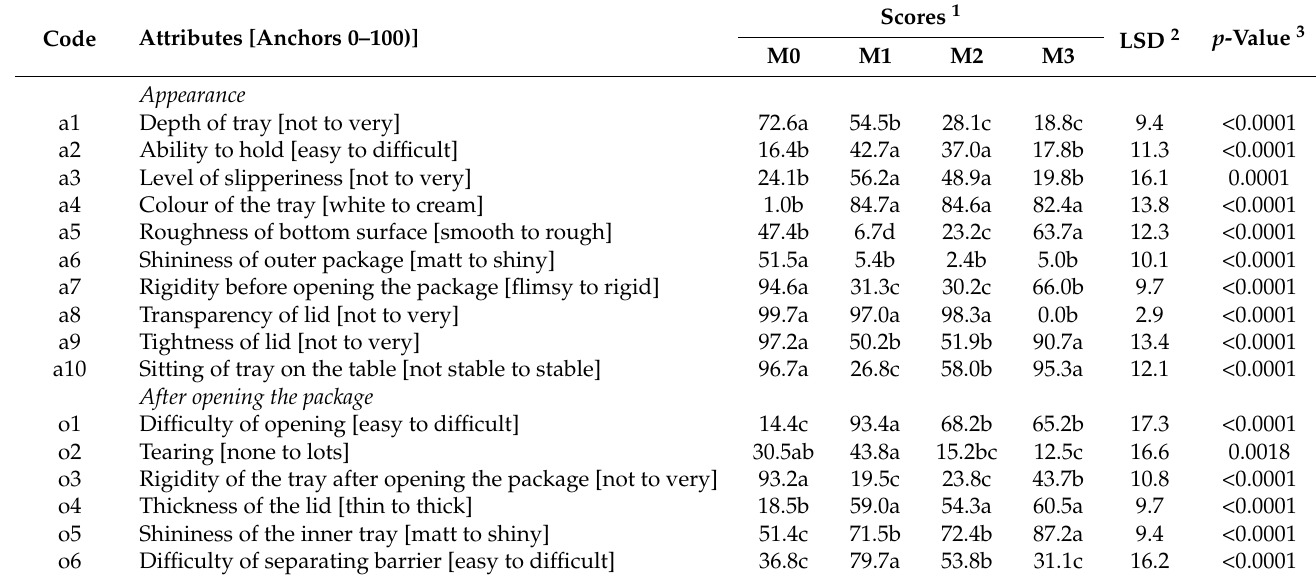
Table 3. Mean panel scores for sensory attributes of the four meat